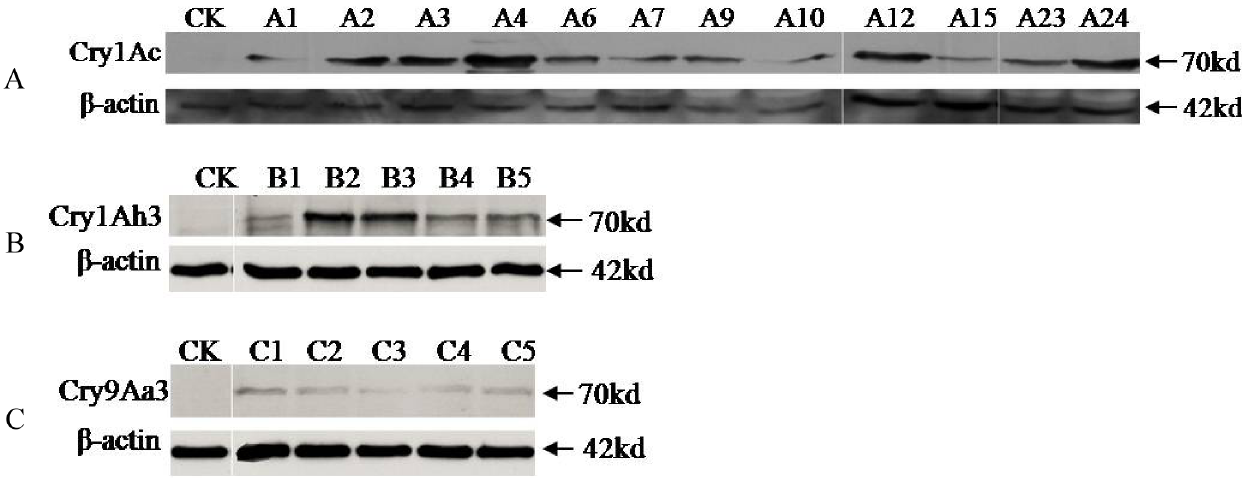
Fig 3. Western blot assay of Bt proteins in the transgenic lines. (A) Western blot assay for the expressionof Cry1Ac. (B) Western blot assays for the expressionof Cry1Ah3. (C) Western blot assays for the expressionof Cry9Aa3,. The arrows indicatethe expectedprotein products (70kD). CK means control, which is wild type of